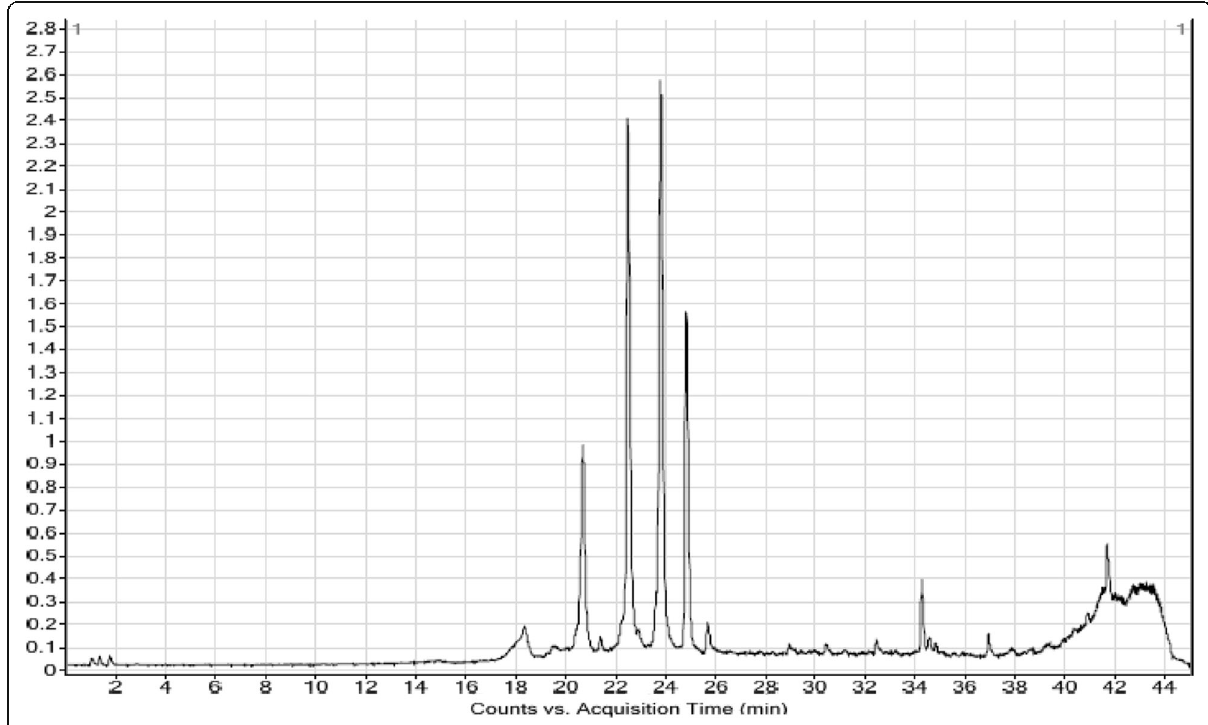
Fig. 3 LCMS chromatogram of the